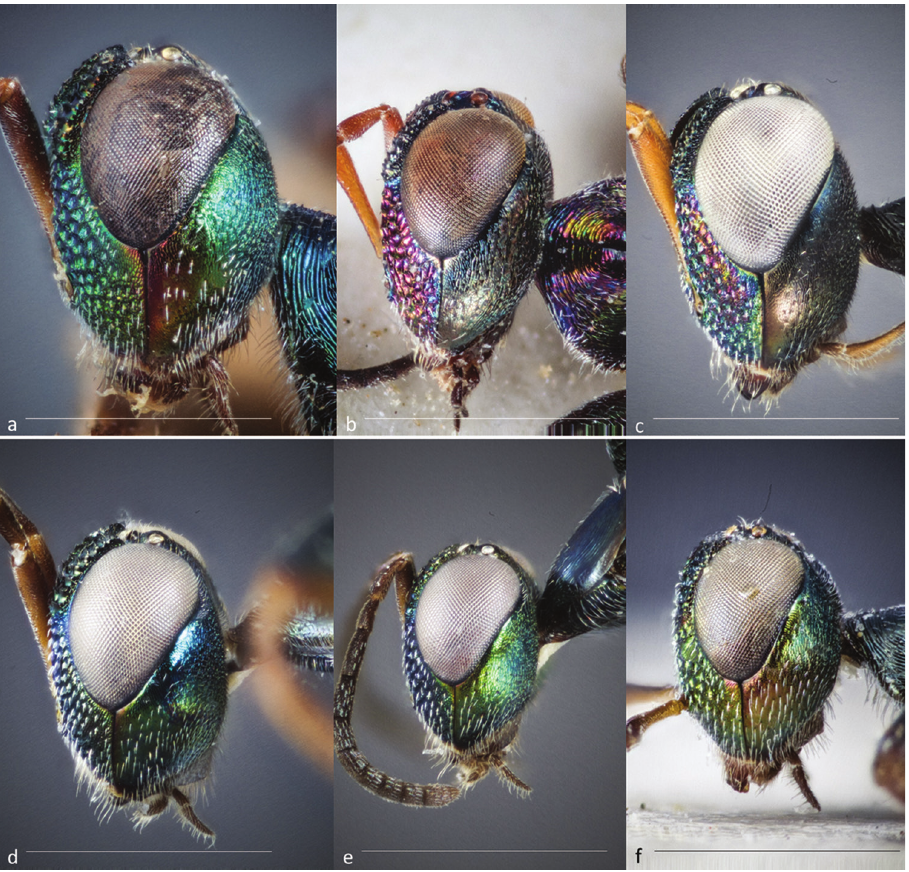
Figure 8. Head (lateral) I a O. ahoma (Mani & Kaul) (imaged specimen: OAh01, holotype) b O. circu- laricollis sp. n. (OCi01, holotype) c O. felix sp. n. (OFe01, holotype) d O. fidelis sp. n. (OFi01, holotype) e O. florea sp. n. (OFl01, holotype) f O. formosa (Giraud) (OFo06). Scale bars: 1